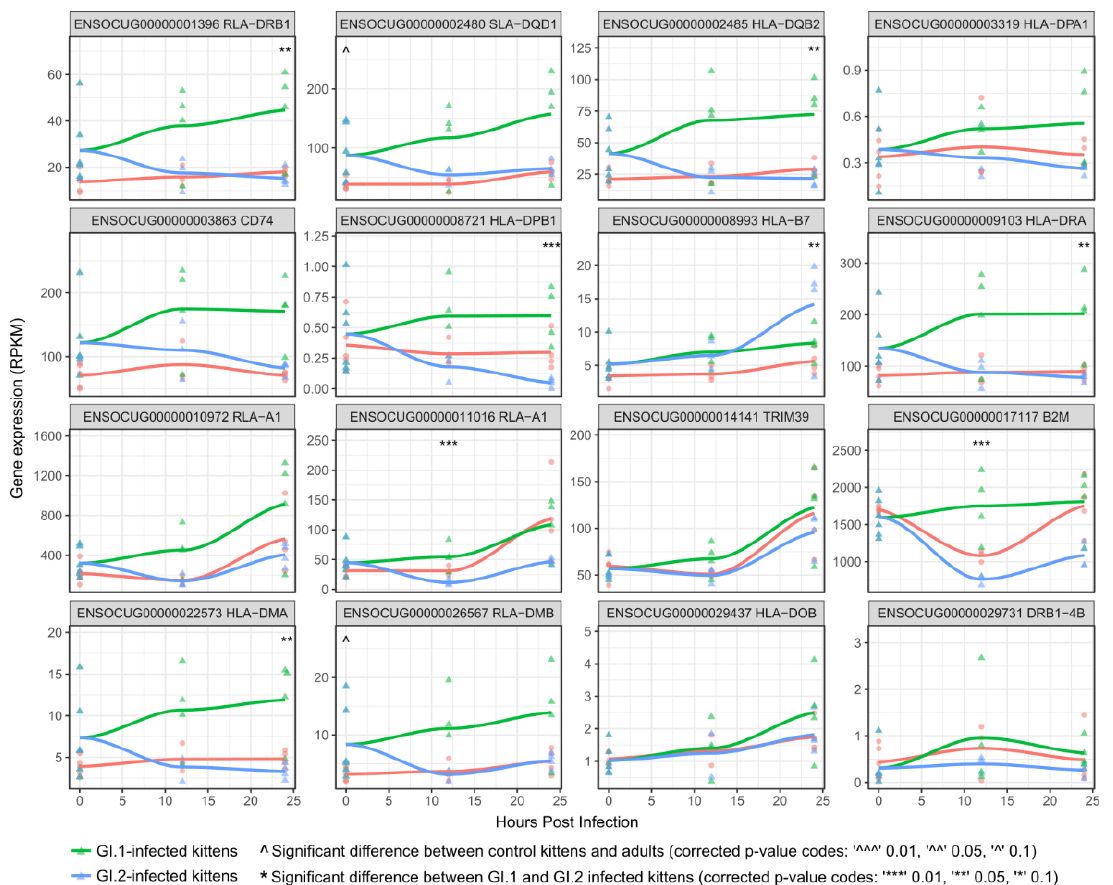
Figure 3. Regulation of genes in the major histocompatibility complex (MHC) during GI.1 and GI.2 infections. Several MHC genes tended to be expressed at a higher level in uninfected kittens compared to uninfected adults. Frequently, these were further upregulated in GI.1-infected kittens, but downregulated in GI.2-infected kittens (e.g., RLA-DRB1, SLA-DQD1, HLA-DQB2, CD74, HLA-DRA, HLA-DMA, and RLA-DMB). The header in each plot gives the Ensembl gene accession followed by the gene symbol.